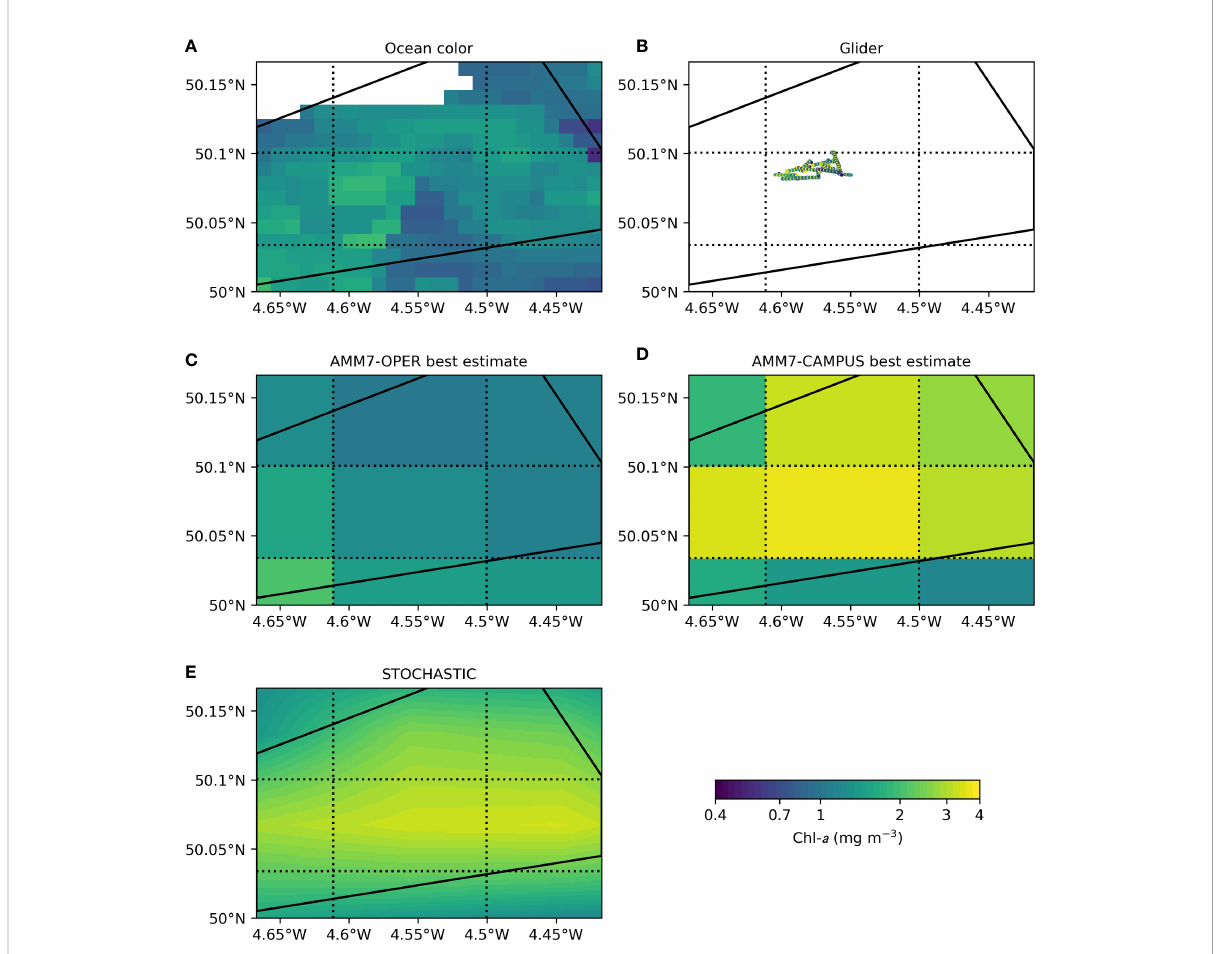
FIGURE 8 Chl- a in the glider region on 20 April 2021, from (A) ocean color (white area is missing data due to cloud), (B) glider observations in the upper 10 m, (C) AMM7-OPER surface best estimate, (D) AMM7-CAMPUS surface best estimate, (E) STOCHASTIC, fi rst four-hour prediction of the day. The solid black lines denote the region the glider was constrained to stay within. The dotted black lines denote the AMM7 model grid. Note the use of a log color